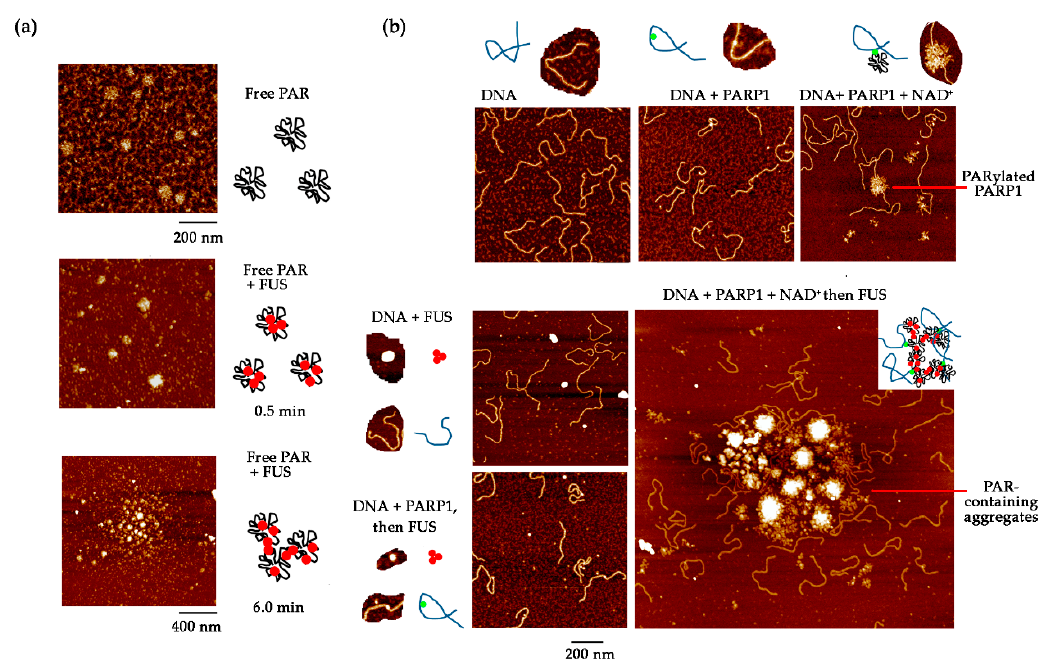
Figure 6. The formation of large DNA-rich assemblies in the presence of FUS after PAR synthesis by PARP1 [101]. ( a ) Representative AFM images of PAR:FUS complexes at different incubation times. PAR: 1µM; FUS: 40 nM. ( b ) Representative AFM images of 1200-bp nicked DNA (1.25 nM) after